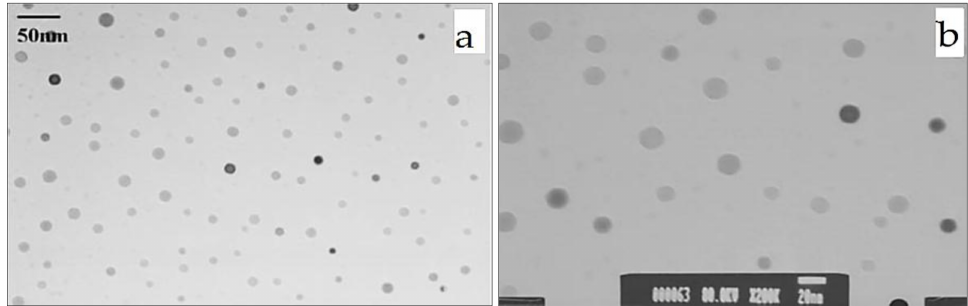
Figure 6. ( a ) FE-SEM image of TiO 2 nanoparticles; ( b ) TEM image of TiO 2 nanofluid [44].